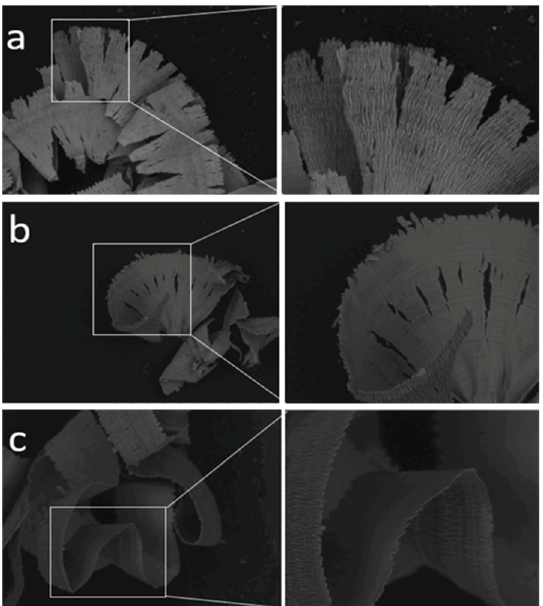
Figure 26. ( a ) Formation of serrated chips when no magnetic field is applied. ( b ) Formation of flat, long and continuous chips when a magnetic field of 0.01 T is applied. ( c ) Formation of flat, long and continuous chips when a magnetic field of 0.02 T is applied, reprinted with permission from Ref. [190] 2022, Elsevier.